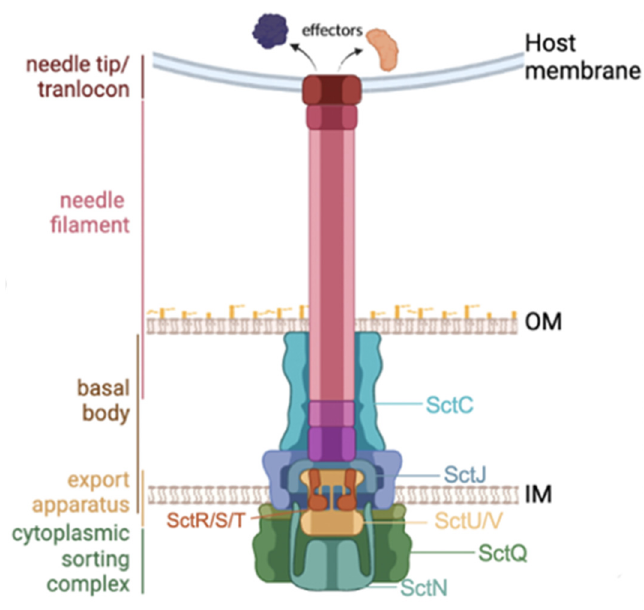
Figure 1. An overview of T3SS core proteins and the bacterial membranes.